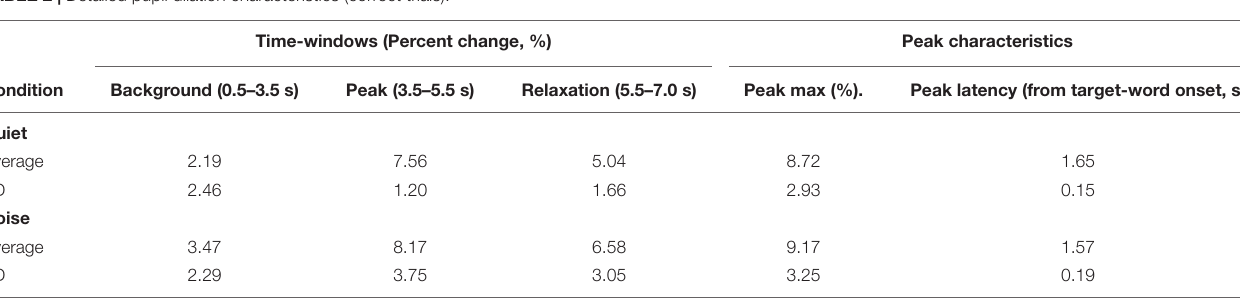
FIGURE 3 | Effect of conditions. Grand-averaged ( N = 10) pupillometry traces showing percent change in event-related pupil dilation (ERPD) for correctly recognized words, presented in Quiet (black line) or +10 dB speech-weighed noise background (gray dashed). Time is given relative to the onset of the noise in noisy background set at 0 s, words are presented at 3 s, and noise fades-out at 6 s. TABLE 2 | Detailed pupil dilation characteristics (correct